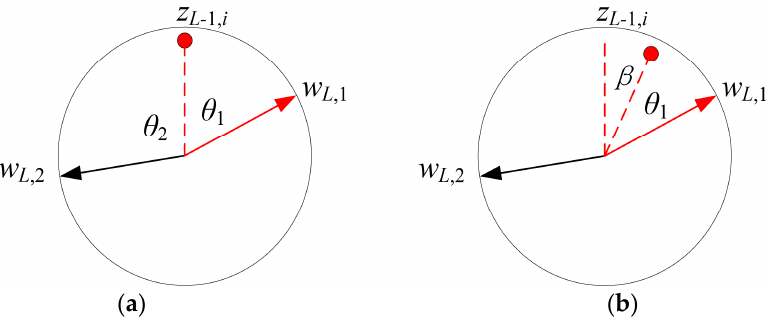
Figure 7. SOFTMAX classification: ( a ) traditional SOFTMAX classification; and ( b ) improved SOFT- MAX